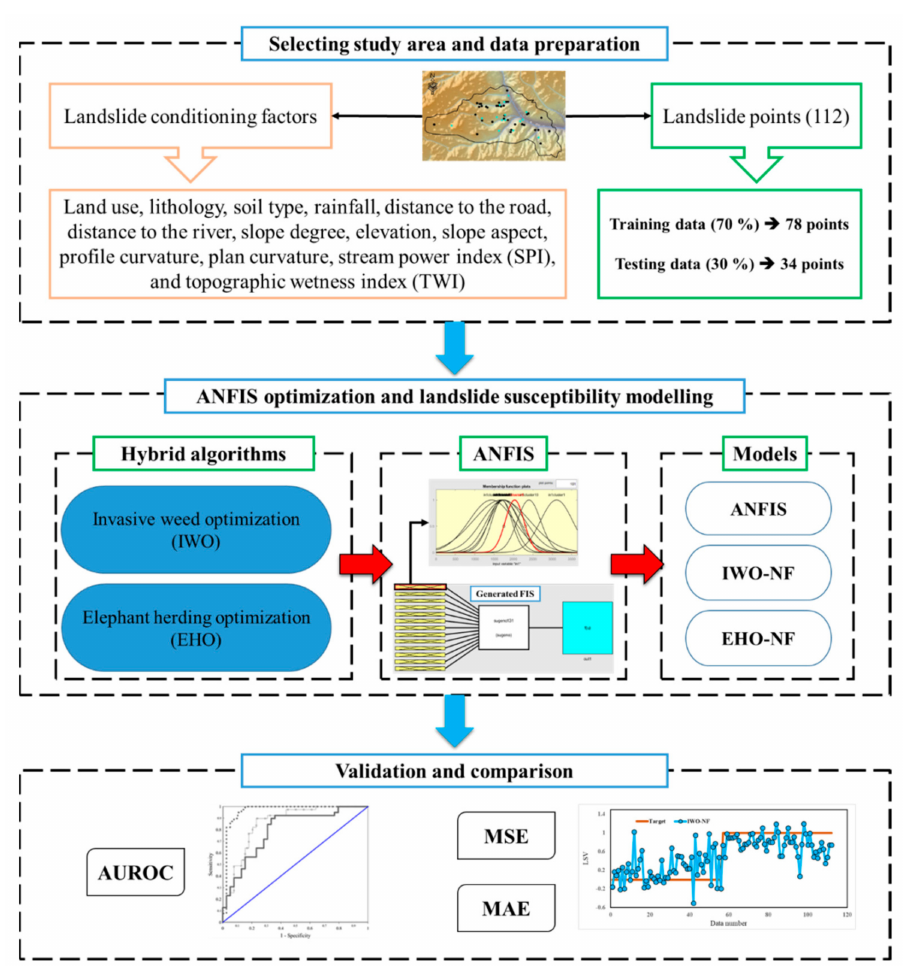
Figure 2. The graphical methodology of this